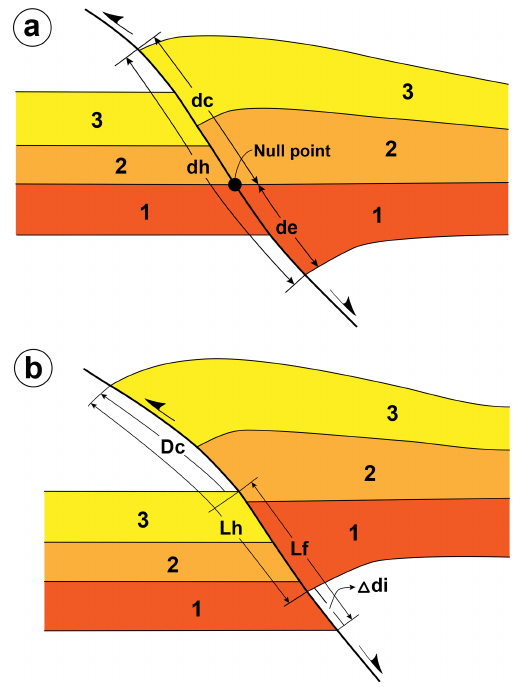
Figure 18. Two methods to determine the inversion ratio in a quan- titative manner by (a) Williams et al. (1989) and (b) Song (1997). In our view, the quantification of inversion tectonics remains a chal- lenge as the deeper section beneath an inversion anticline is typ- ically not well imaged seismically and/or not drilled due to the greater depth. Therefore, a more practical approach is needed to describe inversion tectonics in cases where not all the required ge- ometric elements of a structure can be measured due to subsurface data